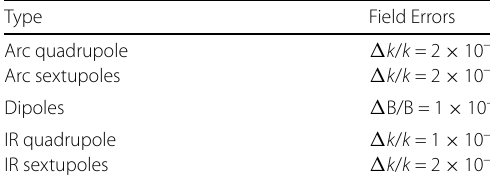
Table 3 rms gradient errors used in all simulations presented in this paper. Note that values are not tolerance specifications, as there is an ongoing iterative process to determine the field